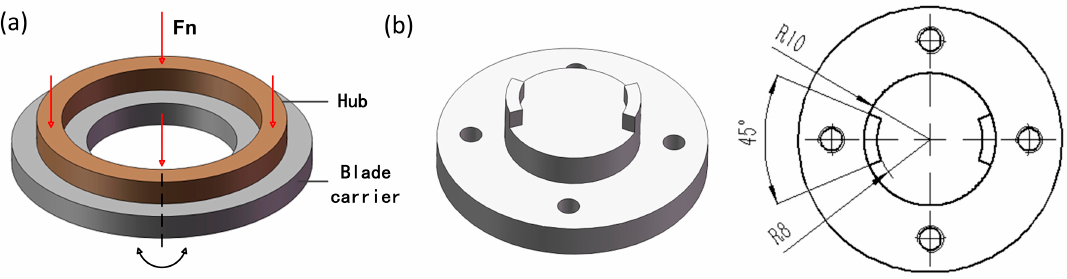
Figure 2. ( a ) Schematic of motion between the hub and blade carrier; and ( b ) Upper specimen.